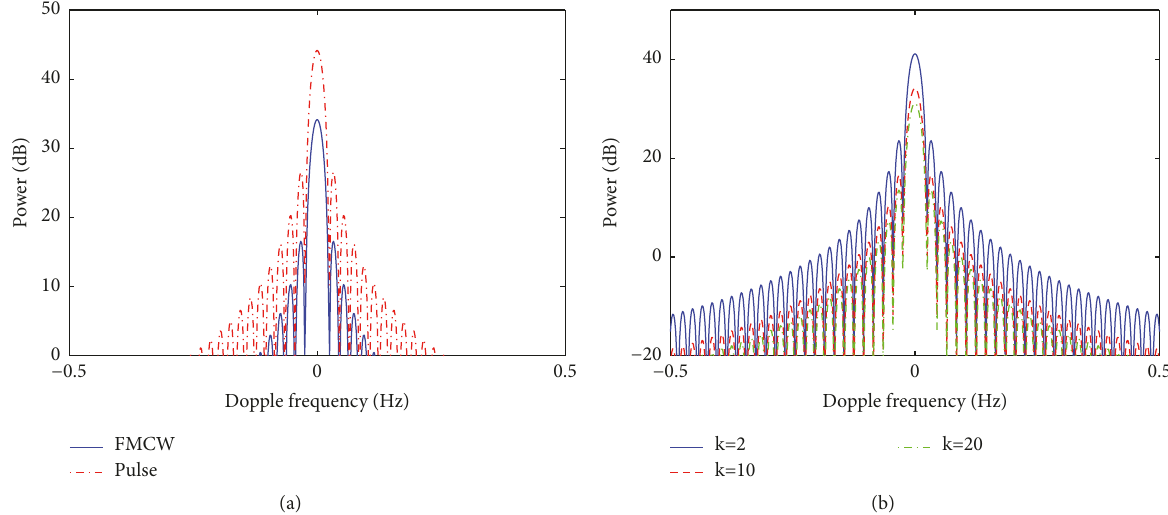
Figure 6: Simulations of vertical normalized ionospheric clutter power: (a) for the pulsed and FMCW waveforms and (b) with different k .